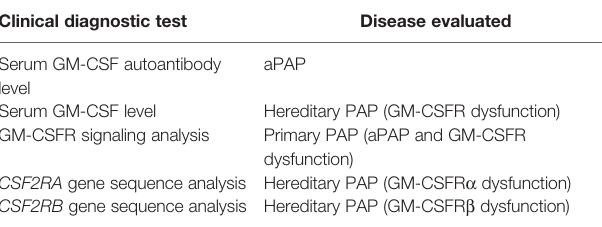
TABLE 2 | Clinical diagnostic testing for pulmonary alveolar proteinosis syndrome. Clinical diagnostic test